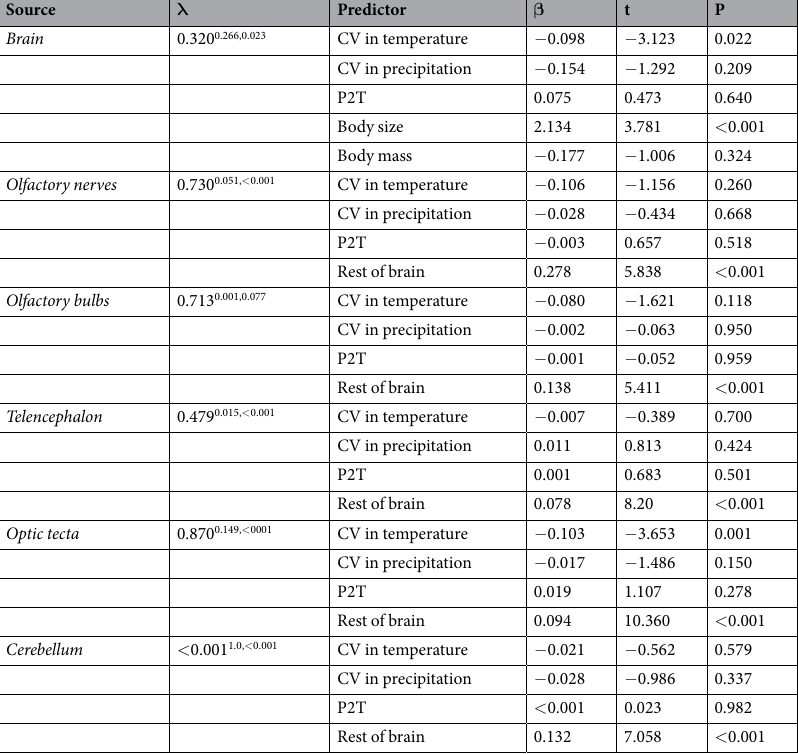
Table 1. Regression models of brain size and size of brain regions in relation to various predictor variables for males across 30 species anurans when controlling for phylogeny. Rest of brain was added as a covariate and was significantly positively related to the size of different brain regions in all models. The partial regression slopes ( β ) for the predictor variable; Phylogenetic signal ( λ ) , t - and P -values are presented for each